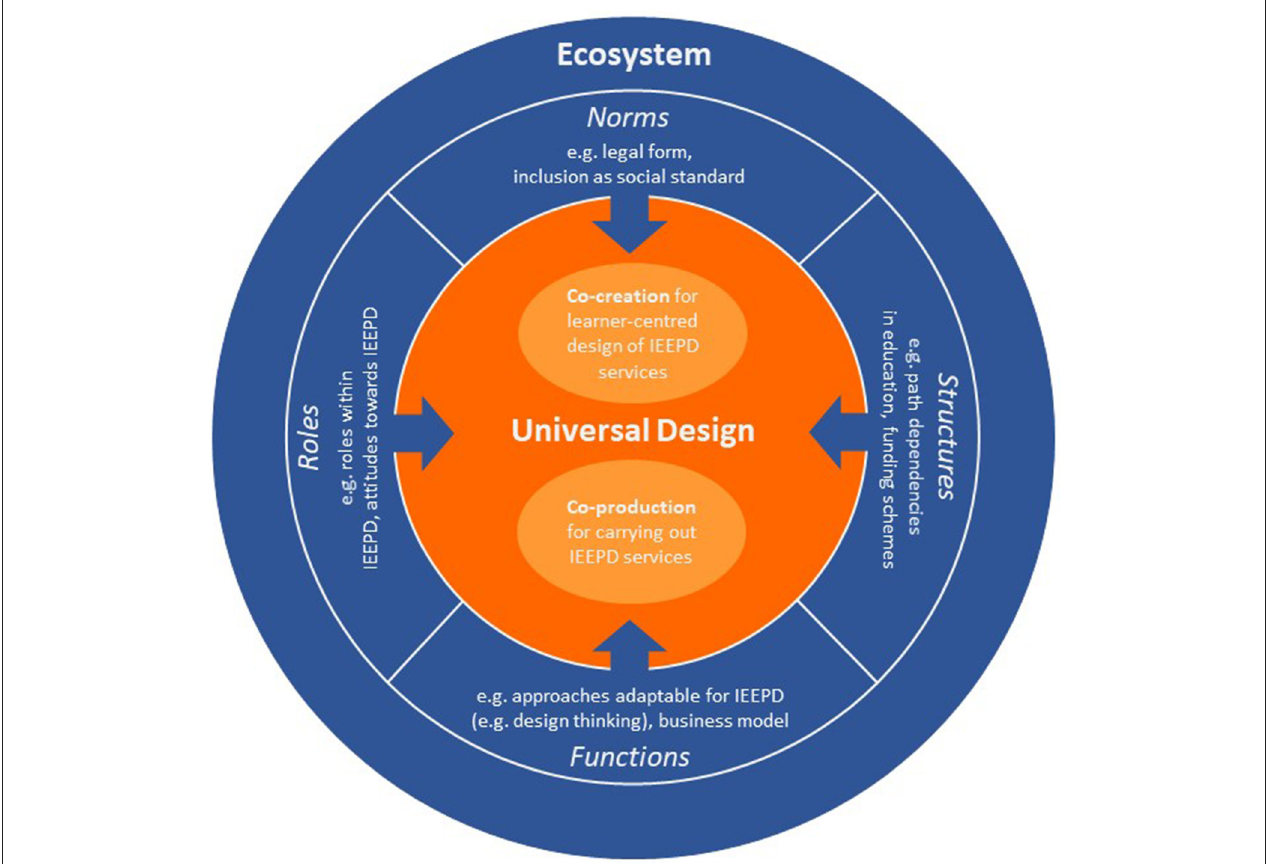
FIGURE 1 | Framework for